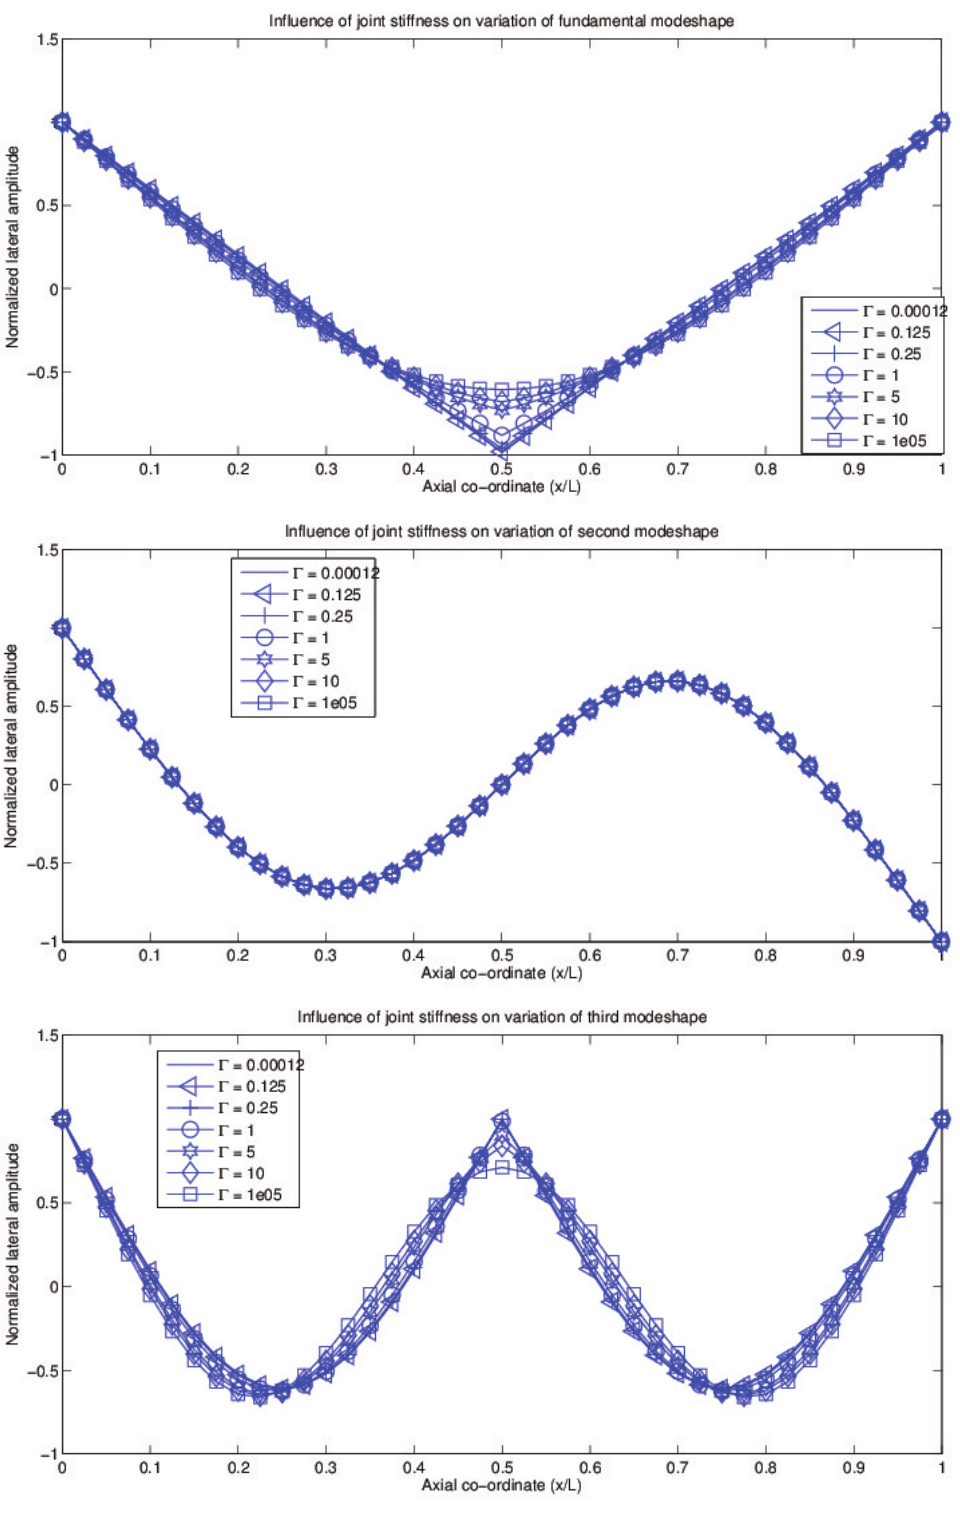
Fig. 4. Influence of joint stiffness on variation of modeshapes (Mode1, Mode2 and Mode3) of free-free beam (Joint located at ξ 2